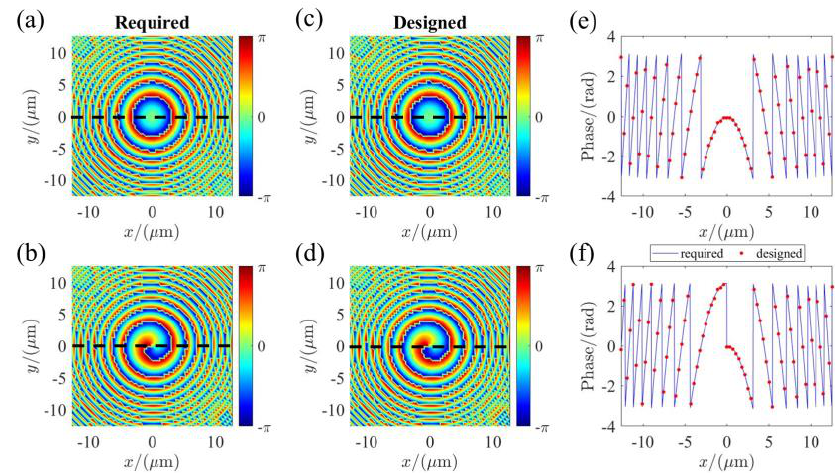
Figure 3. The simulated phase profiles for orthogonal circular polarizations. ( a , b ) are the required hyperbolic phase profile and focusing vortex phase profile, respectively; ( c , d ) are the optimized phase profiles offered by the nano-pillars for LCP and RCP incidence, respectively; ( e , f ) the corresponding phase profiles along the dashed line y = 0.